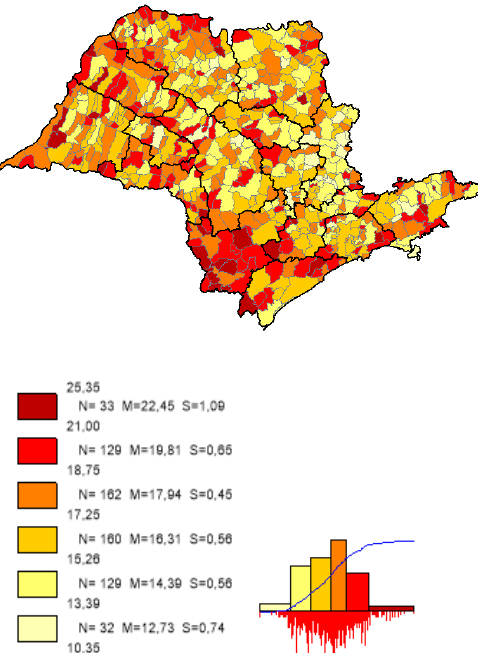
Figure 8. Distribution map of IM rates average results in the municipalities of the state of SP. Note: Choropleth maps, consisting of six divisions, using the following limits—minimum value; 5th percentile; 25th, 50th and 75th percentiles; 95th percentile and maximum value. For each interval, the number (N) of municipalities, their mean (M) and standard deviation (S) are described. The histograms contain bars proportional to the number of localities in each division ( Philcarto images).